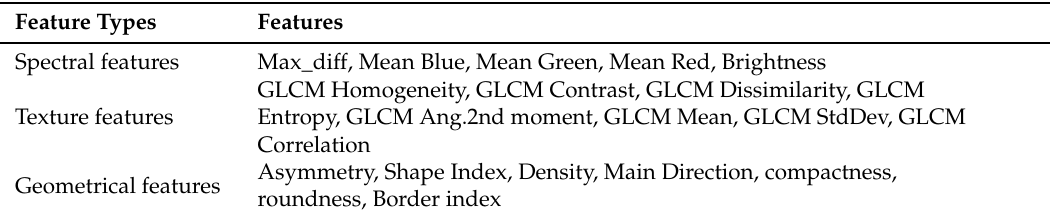
Table 1. Details of object’s